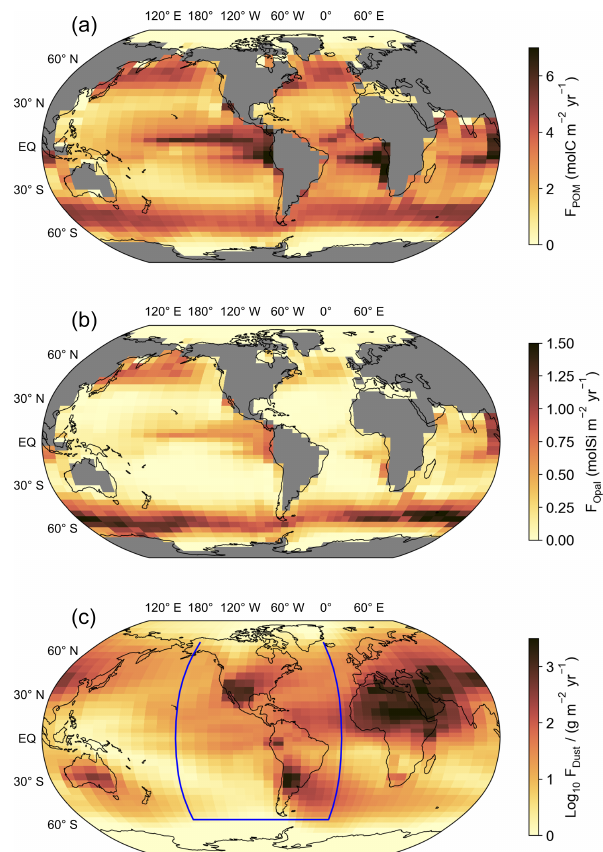
Figure 1. (a) Export fluxes of particulate organic matter (POM) and (b) biogenic opal calculated in the biogeochemical model from prognostic equations (Parekh et al., 2008). The distribution of cal- cium carbonate (CaCO 3 ) production is the same as for POM but scaled by the Redfield ratio and a Ca to P ratio of 0.3 in calci- fiers. (c) Log10 of the global dust flux estimated by Mahowald et al. (2006). The blue line indicates the transect for the section plots of Fig.